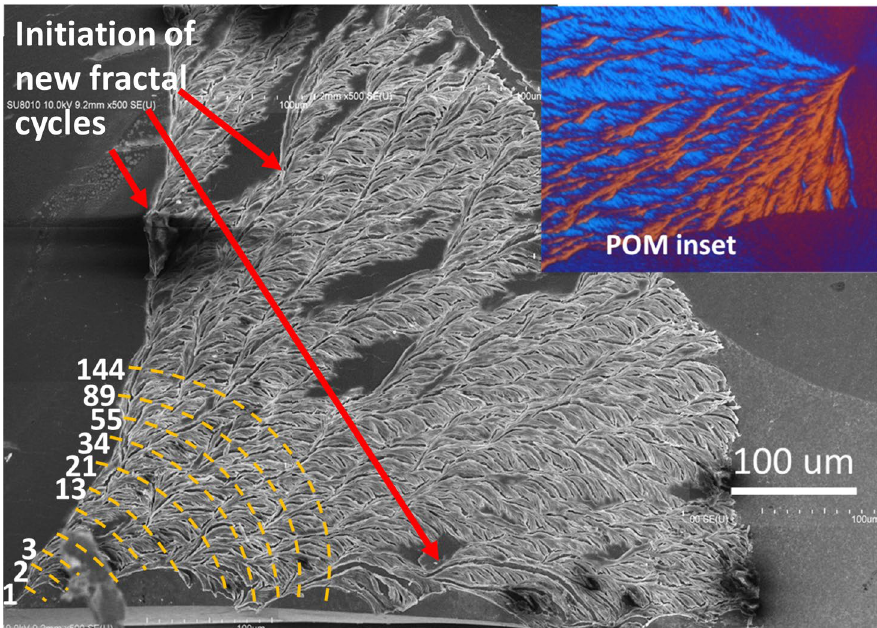
Figure 13. Stacked SEM micrographs (by zip-stacking several individual micrographs side-by-side to an integral mega-graph) for complete view of a single explosive sector in the sector-face PLLA spherulites crystallized from PLLA/PMMA (80/20) blend crystallized at 115 °C after solvent-etching, yellow dashed-lines indicate lamellar fractal-branching cycles. Inset POM (flipped to its mirror image) on upper-right